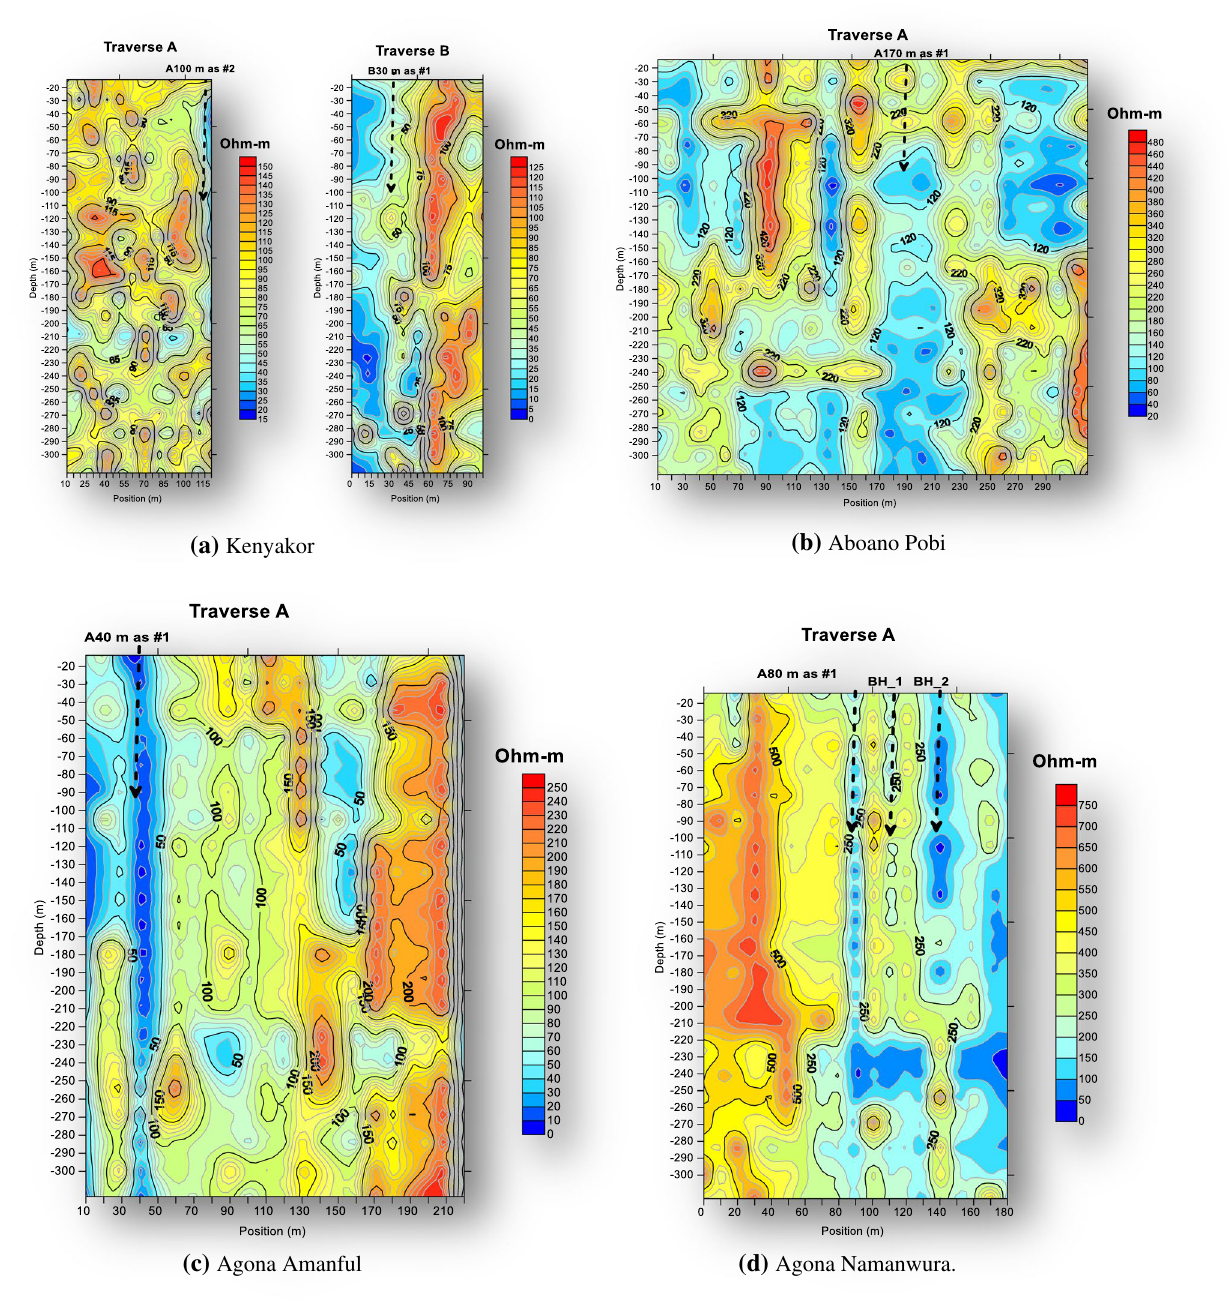
Fig. 2 ( a – d ) Two-dimensional-apparent geo-electrical resistivity pseudo-section of the surface at four communities of the study area underlain by the Eburnean Plutonic